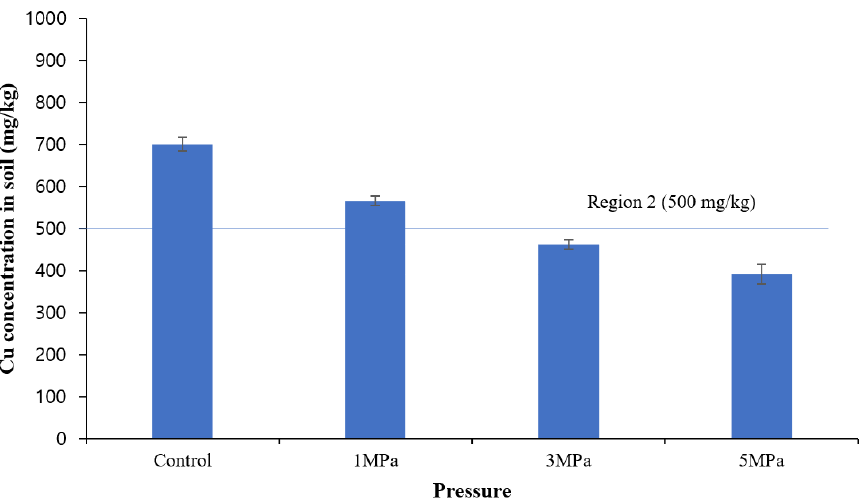
Figure 3. Cu concentrations remaining in the soil after high-pressure washing at 1, 3 and 5 MPa.